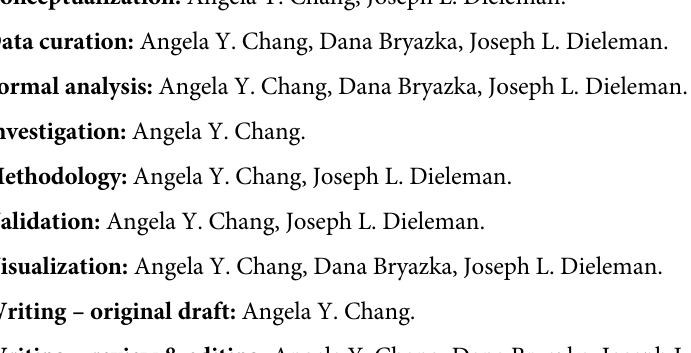
Table A3. Summary statistics of 50 SGD model runs. Table A4. Summary statistics of study population. Table A5. Covariates and their regression coefficients. Table A6. Observed preva- lence and estimated multimorbidity-adjusted annual spending per treated case for the “other” conditions. Table A7. Regression coefficients for disease combinations with prevalence rate of greater than 100 per 100,000 (ordered by